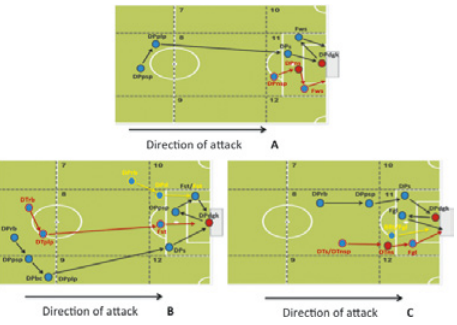
Figure 4. Illustration of offensive patterns that resulted in wide shot (A), in shot on target (B) and in goal scored (C) in Progression to the Target Game. See Table 1.